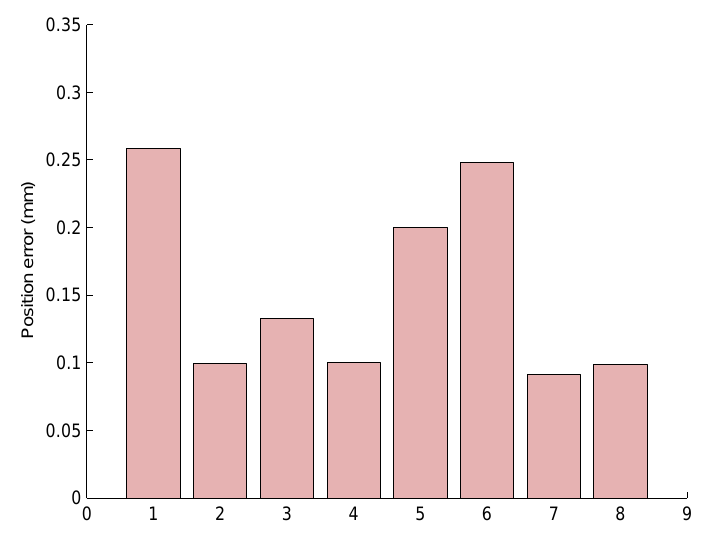
Figure 4. Static point positioning